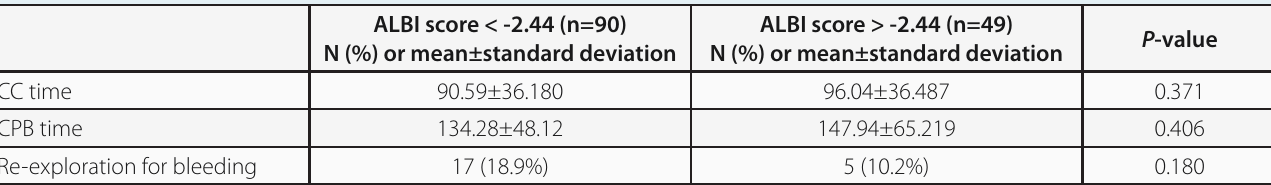
Table 3. Comparison of the operative data of the patients according to the ALBI score greater and lesser than -2.44. ALBI score < -2.44